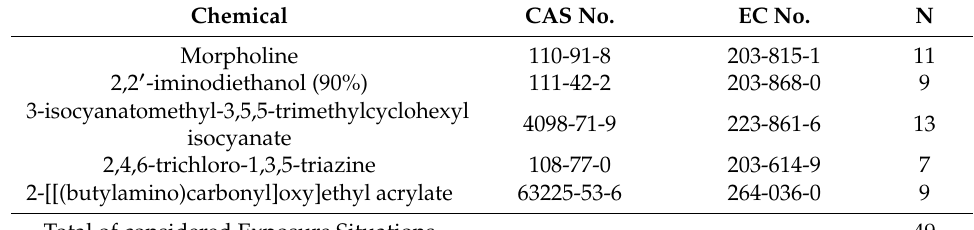
Table 1. Chemicals considered in this study, with their chemical abstract service number (CAS No), European community number (EC No) and number of communicated exposure situations